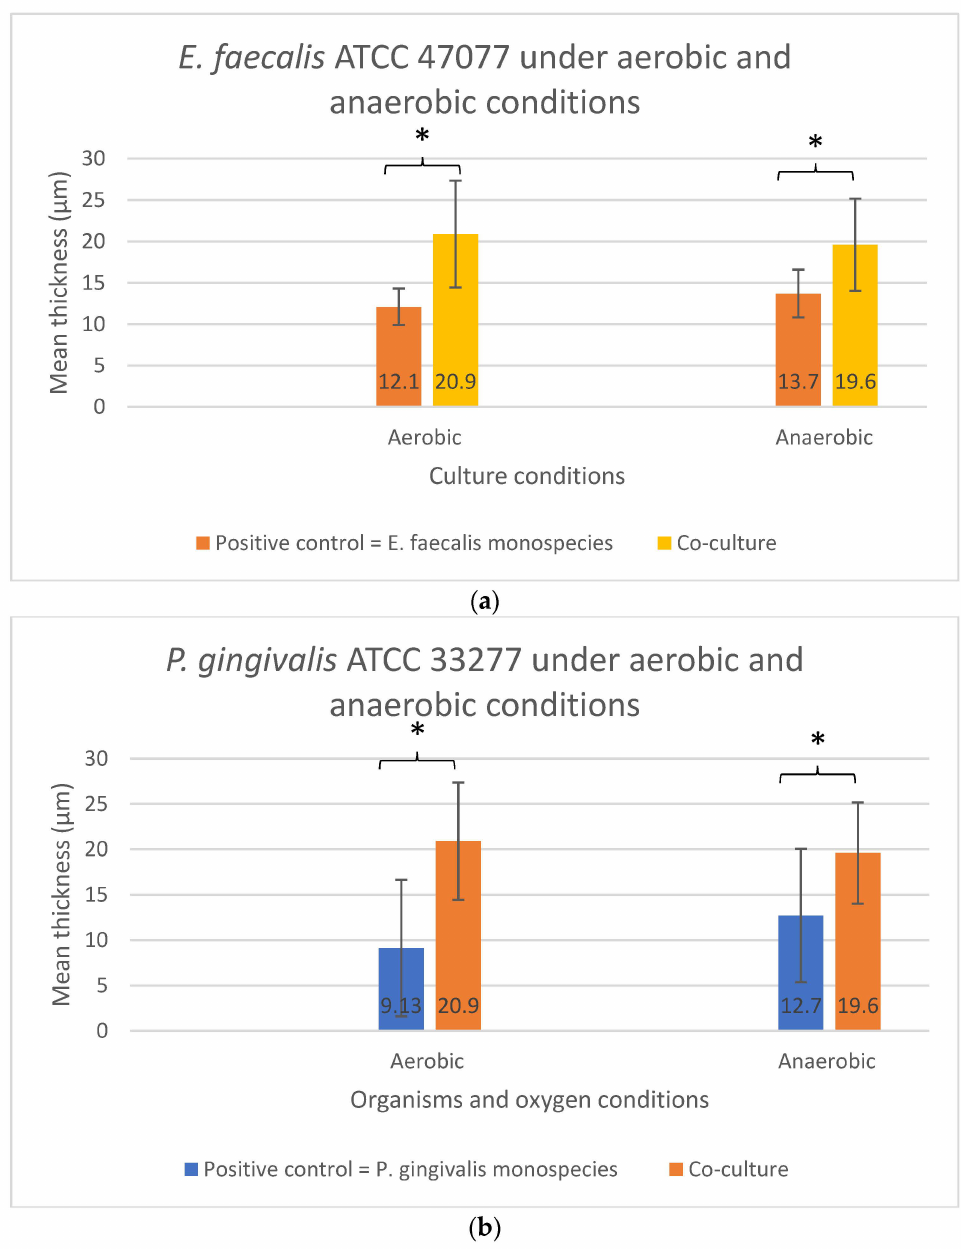
Figure 6. The biofilm thickness of ( a ) E. faecalis and ( b ) P. gingivalis cultured independently under aer- obic and anaerobic conditions based on the co-culture and mono-culture models. Asterisks (*) denote a statistically significant difference ( p < 0.05). Data represent the mean and standard